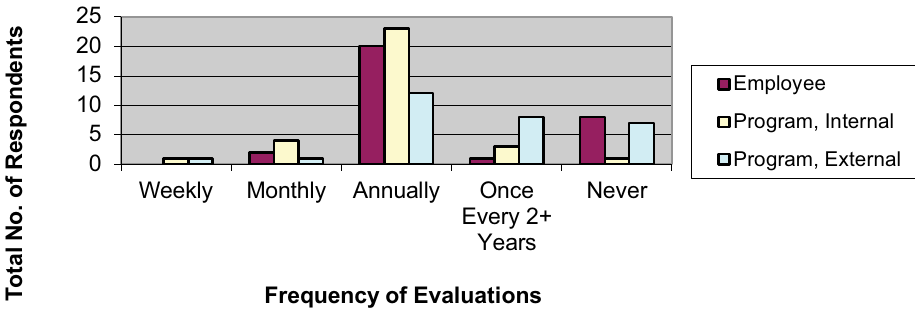
Figure 10. Reported frequencies and types of evaluation in wildlife reintroduction programs.